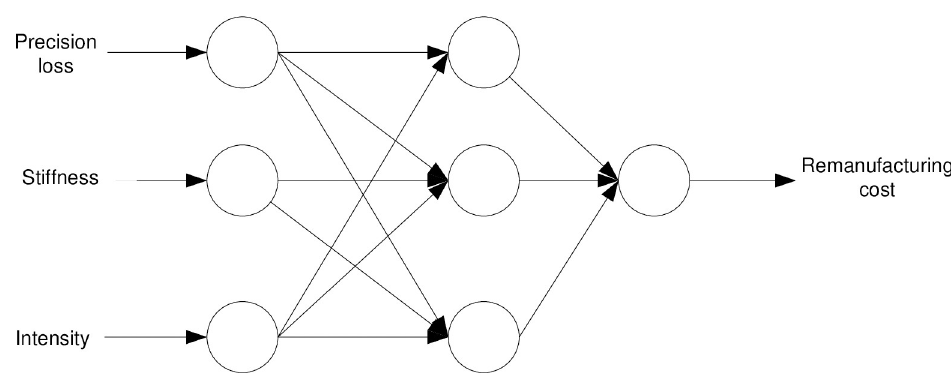
Fig 1. Spindle remanufacturing cost prediction model based on the ANN.